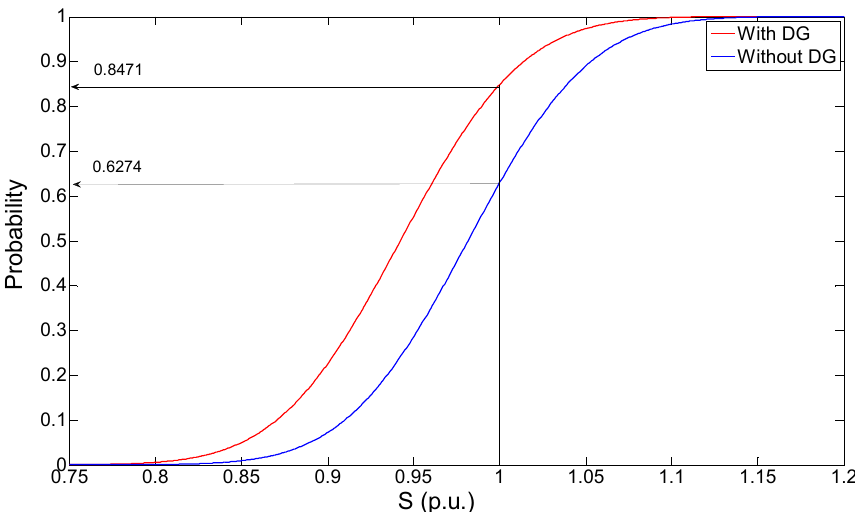
Figure 4. Power flow through lines 4–5 when contingency 3 occurs.